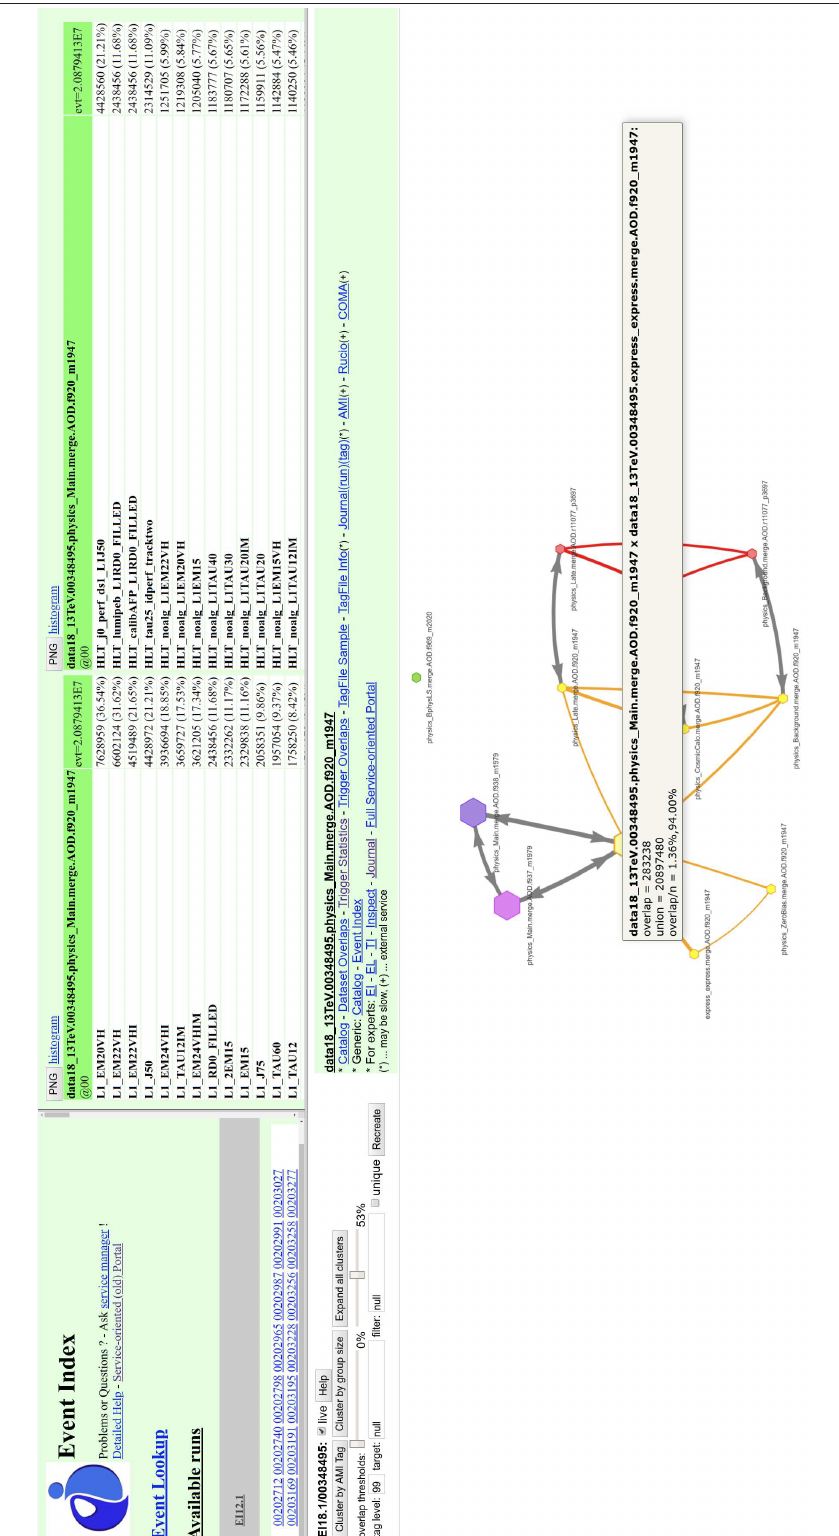
Figure 2. Data-oriented Graph Web